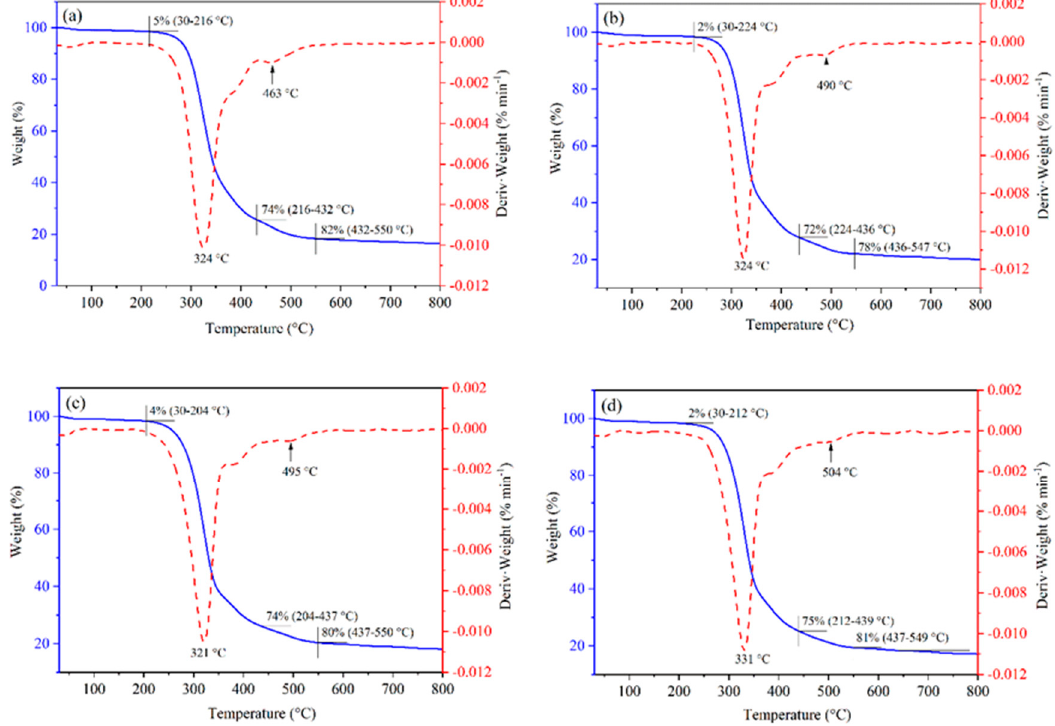
Figure 4. The TG and DTG curves of ( a ) RPUF, ( b ) RPUF / SiO 2 (7 wt %), ( c ) RPUF / PS (10 wt %), and ( d ) RPUF / PB (10 wt %).